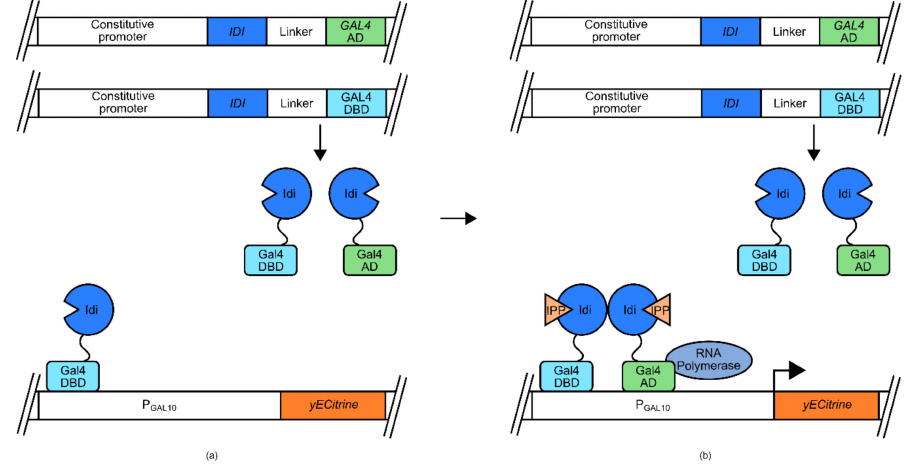
Figure 5. Isopentenyl-pyrophosphate (IPP) biosensor for use in S. cerevisiae . Two fusion proteins were used in the biosensor. The first was IPP isomerase (Idi)-tether-Gal4 activation domain (Gal4 AD). The second was IPP isomerase (Idi)-tether-Gal4 DNA binding domain (Gal4 DBD). Both fusion protein genes were under the regulatory control of constitutive promoters. Also used in this biosensor was a yECitrine gene under the control of P GAL10 : ( a ) Under low IPP concentrations, the fusion proteins were expressed, but had no effect on yECitrine expression; ( b ) Under increased IPP concentrations, the two fusion proteins are able to dimerize via the Idi domains. Gal4 DBD localized the dimer to P GAL10 , while Gal4 AD induced the transcription of yECitrine . Thus, increases in IPP concentration were correlated with increases in the yECitrine